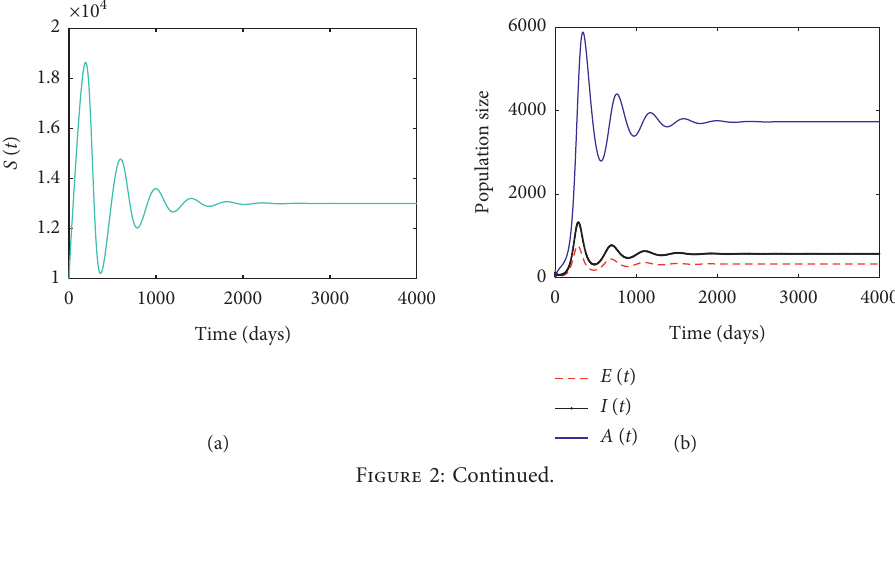
> 1 when the vaccination validity τ is 15 days. 0 � 6 . 0